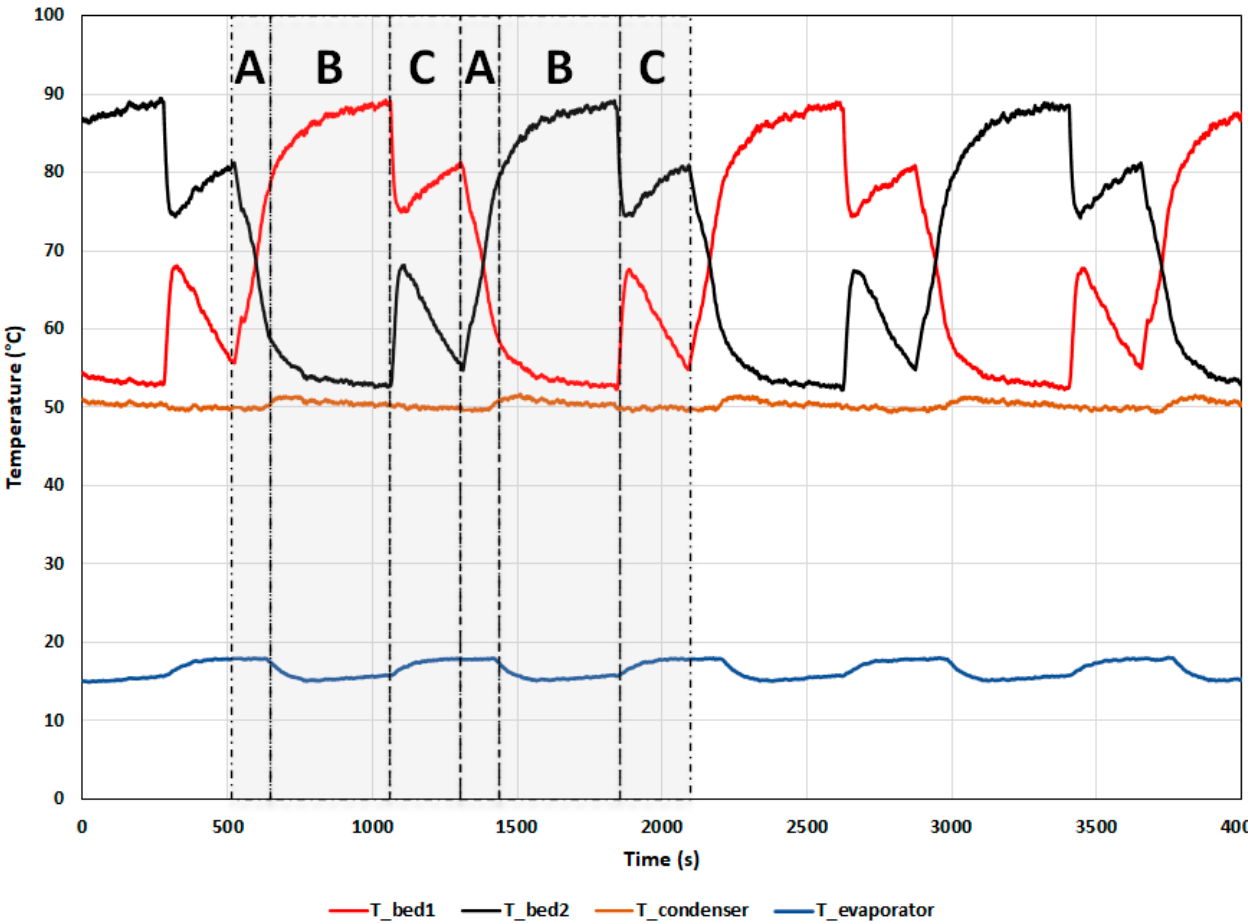
Figure 13. Experimental temperature profile for prototype adsorption chiller with mass recovery with overall cycle time of 750 s. T hw_in = 90 °C, T cw_in = 50 °C, and T chw_in = 18 °C.